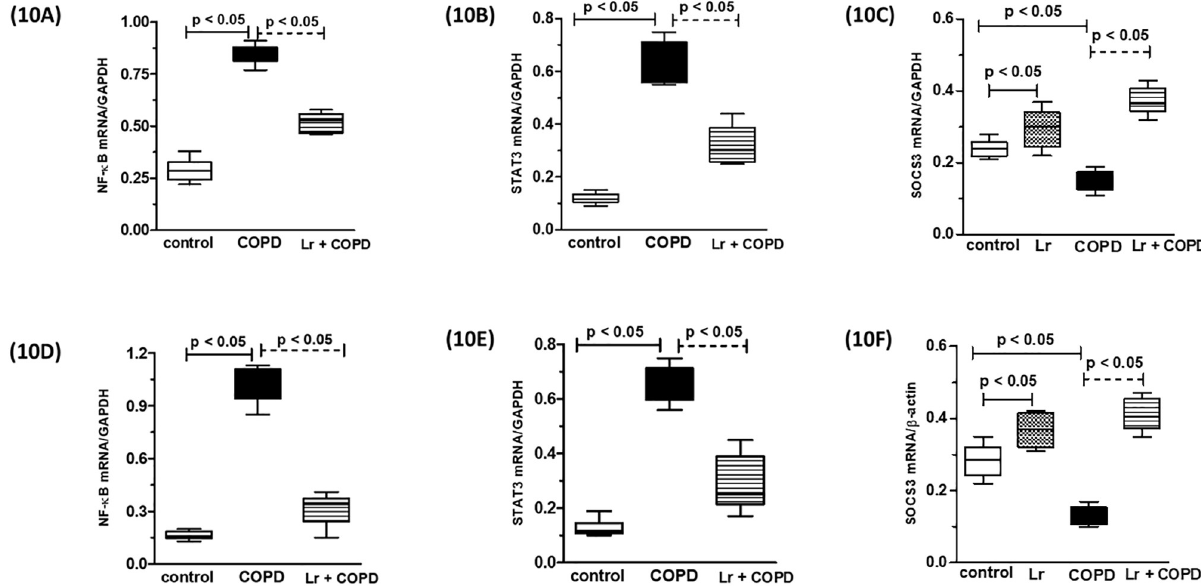
Fig 10. Transcription factors in murine bronchial epithelial cells and in BEAS. The mRNA expression of the NF- κ B, STAT3 as well as SOCS3 in murine bronchial epithelial cells from the control, COPD, and Lr + COPD groups is illustrated in Figs 10A, 10B and 10C, respectively. Figs 10D, 10E and 10F presents the mRNA expression of the NF- κ B, STAT3 as well as SOCS3 in human bronchial epithelial cells (BEAS) from the control, COPD, and Lr + COPD groups. After exposure of both airway epithelial cells, murine and human, to cigarette smoke extract (CSE) and treatment with Lactobacillus rhamnosus ( Lr ), the mRNA expression for NF- κ B, STAT3 and SOCS3 in lung tissue was evaluated through Real Time-PCR. The values were normalized by the GAPDH expression and expressed by arbitrary units. The assays were performed in triplicate. Results were considered significant when p <